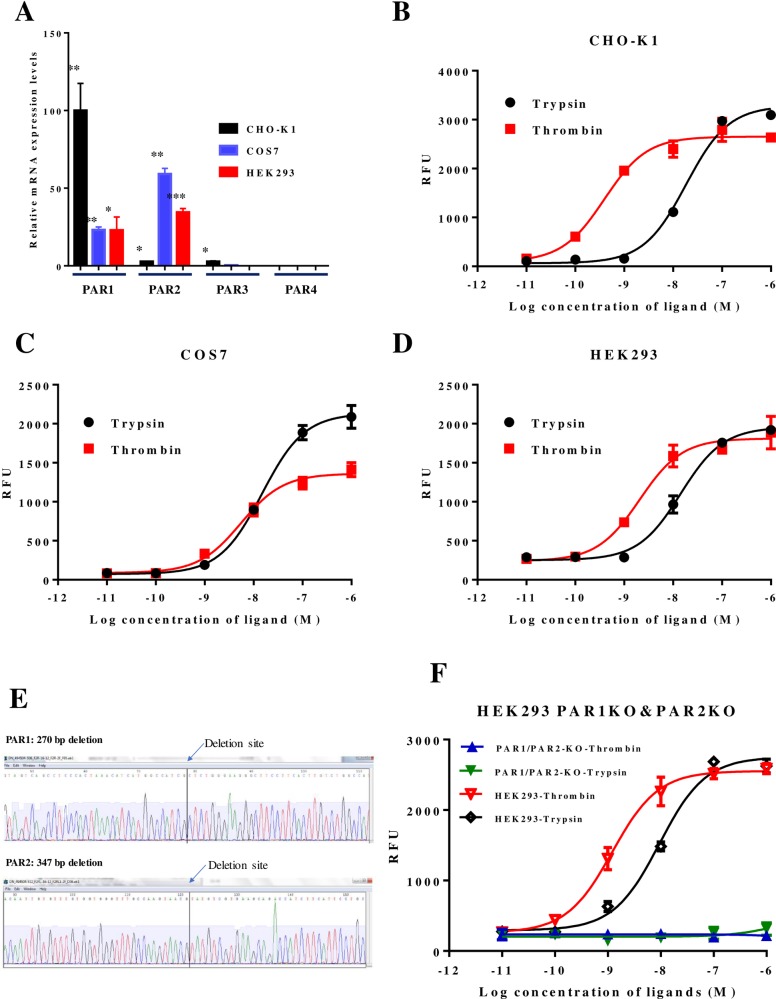
CHO-K1, COS7, and HEK293 cells express PAR1 and PAR2 receptors.A. CHO-K1, COS7, and HEK293 cells naturally express high levels of PAR1 and PAR2 mRNA but express little or no PAR3 and PAR4 mRNA. qPCR analysis was used to quantify the mRNA expression. Specific primers for each of PAR1, PAR2, PAR3, and PAR4, were used to quantify the respective mRNA expression using cDNA made from each cell line as the templates. β-actin primers were used to quantify β-actin mRNA expression as the internal controls. The relative mRNA expression of PAR1, PAR2, PAR3, and PAR4 were first normalized using β-actin expression, and then normalized using the PAR1 expression level in CHO-K1 cells, which is arbitrarily set as 100%. The relative expressions of other genes are represented as percentage of PAR1 mRNA level in CHO-K1 cells. The results shown are mean ± sd (n = 3). Statistical analysis (One-Way ANOVA) shows that compared with the mRNA expression of PAR4, which is undetectable in these cells, CHO cells express high levels of mRNAs for PAR1 (** p = 0.0037), PAR2 (* p = 0.023), and PAR3 (* p = 0.035); COS7 and HEK293 cells express high level of mRNAs for PAR1 (** p = 0.0029, * p = 0.032, respectively) and PAR2 (** p = 0.0013, ** p = 0.0027, respectively) without expressing detectable PAR3 and PAR4 mRNAs. B, C, D. CHO-K1, COS7, and HEK293 cells naturally express PAR1 and PAR2 receptors and respond to thrombin (PAR1 ligand) and trypsin (PAR2 ligand) stimulations. FLIPR assays were used measure receptor activation as indicated by intracellular Ca2+ mobilization. Relative fluorescent units (RFU) are the readout for fluorescent intensities for Ca2+ mobilization signals. Various concentration of thrombin or trypsin were used as the ligands to activation the receptors. The assays were performed in triplicates at each data point and mean ± sd are shown. E. Sequencing analysis of the genomic DNA from par1 & par2 knock out HEK293 cells. The results show that a 270 bp deletion in par1 gene and a 347 bp deletion in par2 gene have been achieved. The deletions removed the coding regions from TM2 to TM3 for both PAR1 and PAR2 proteins. The vertical lines indicate the deletion sites. F. Characterization of par1 & par2 knock-out HEK293 cells. FLIPR assays were used to characterize receptor activation as indicated. Wild type HEK293 cells were used as the positive control. The assays were performed in triplicates at each data point and mean ± sd are shown.